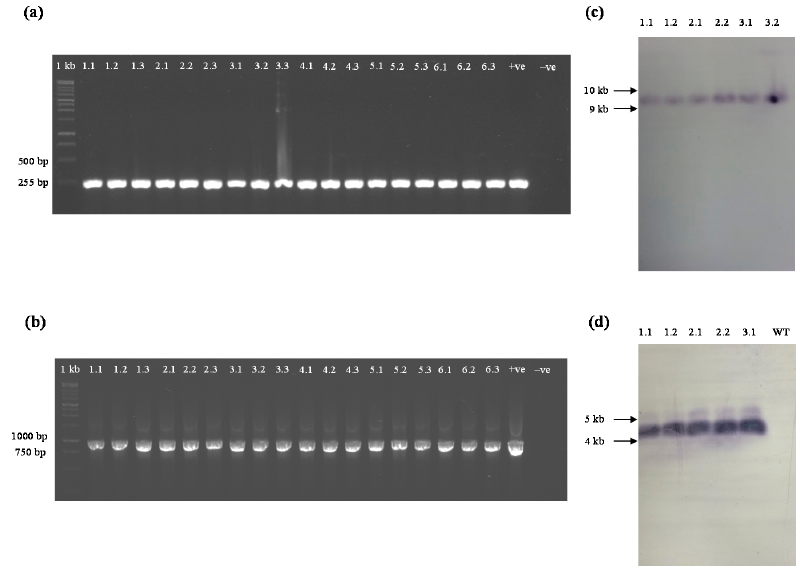
Figure 4. Detection of yefM Spn and yoeB Spn -GFP transgenes in hybrids of transgenic A. thaliana